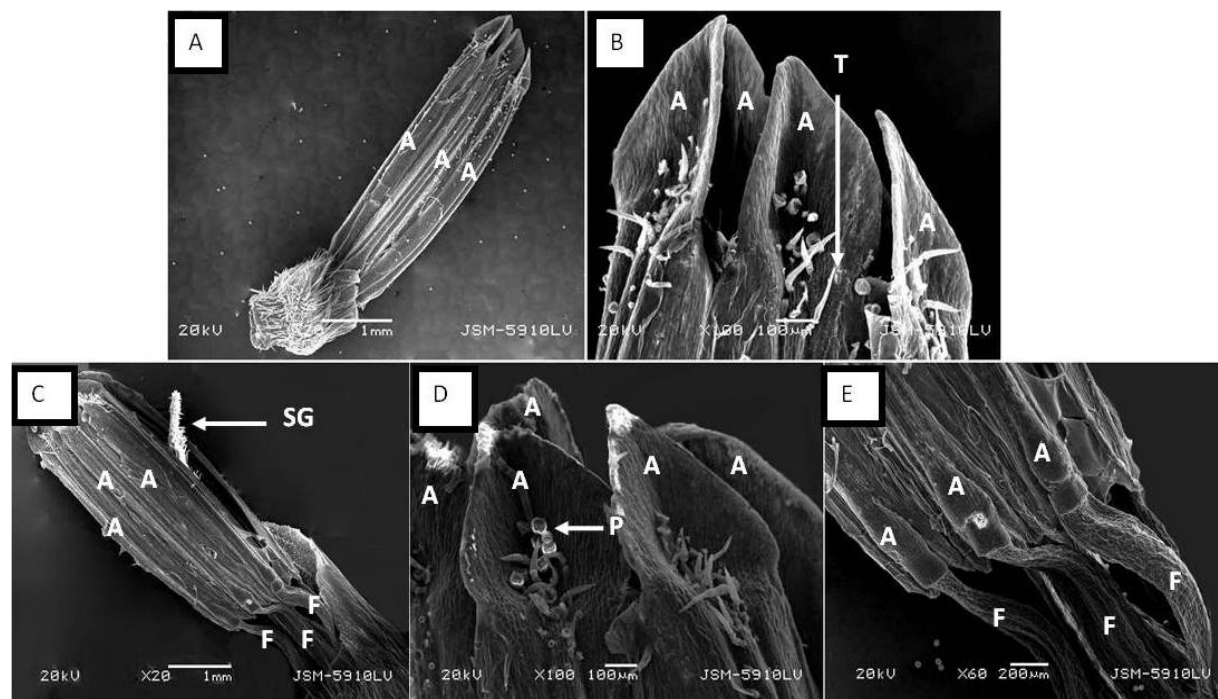
Fig. 3. SEM analysis of stamens in young (A, B) and mature hermaphrodite (C, D, E) florets in H. annuus . A. Long anthers and short filaments; B. Anthers with sharp tops and trichomes; C. Long anthers, long filaments, anther tube and stigma that is divided in two parts and stretched out from anther tube; D. Anthers with sharp tops and trichomes; E. Long and curled filaments. A: Anther; F: Filament; P: Pollen; SG: Stigma; T: Trichomes